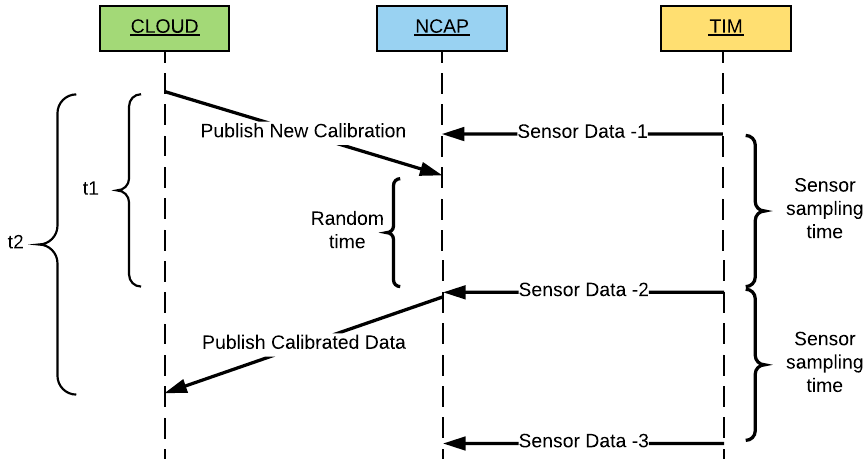
Figure 34. Sequence diagram that illustrates how the auto-calibration latency was